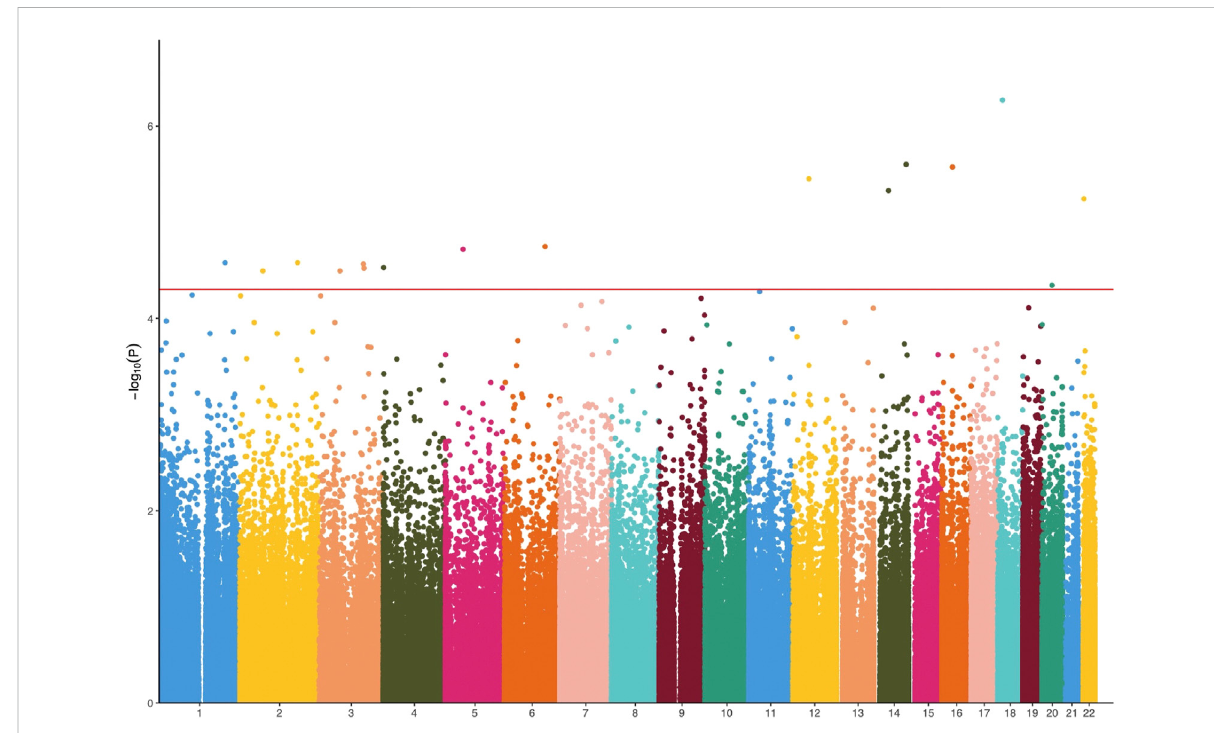
FIGURE 2 Manhattan plots of p values against their respective chromosomal positions for methylome-wide association study. The red line represents the genome-wide signi fi cance level ( p < 5 × 10 – 5